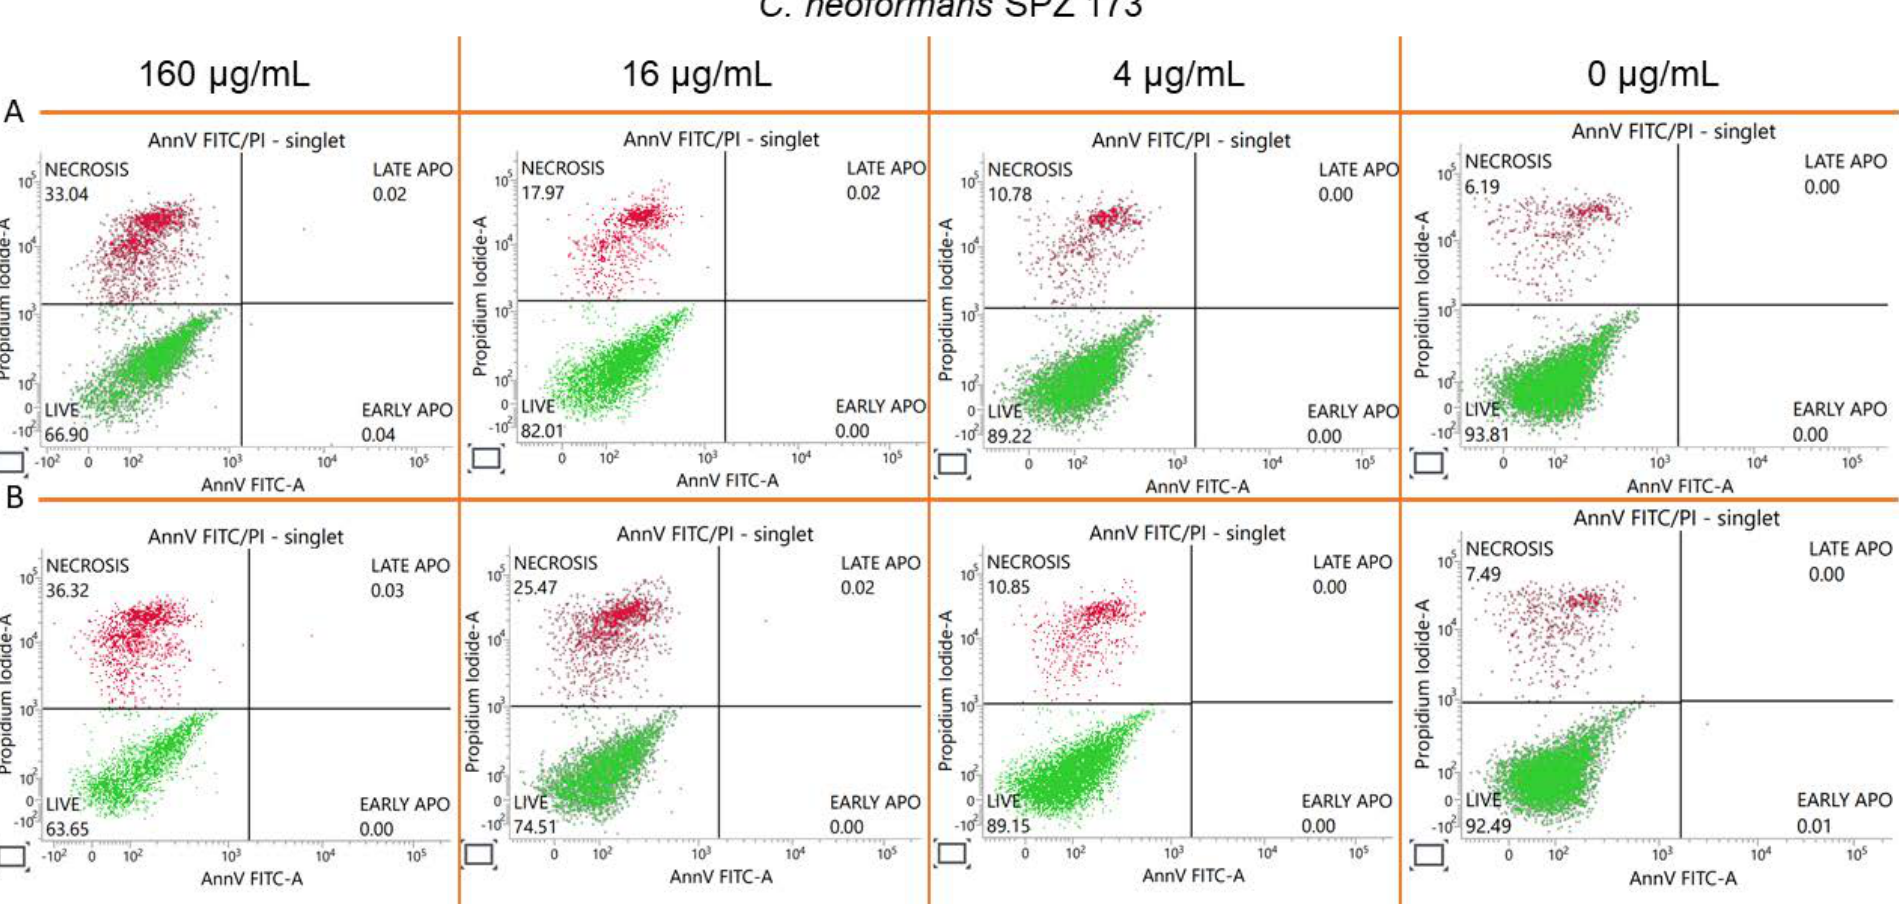
Figure 4. Flow cytometric analysis of the cell death type of C. neoformans SPZ173 treated with 5h . Legend: ( A ) cells; ( B ) protoplasts; EARLY APO means early apoptosis; LATE APO means late apoptosis. Data represent mean ± SD, n =